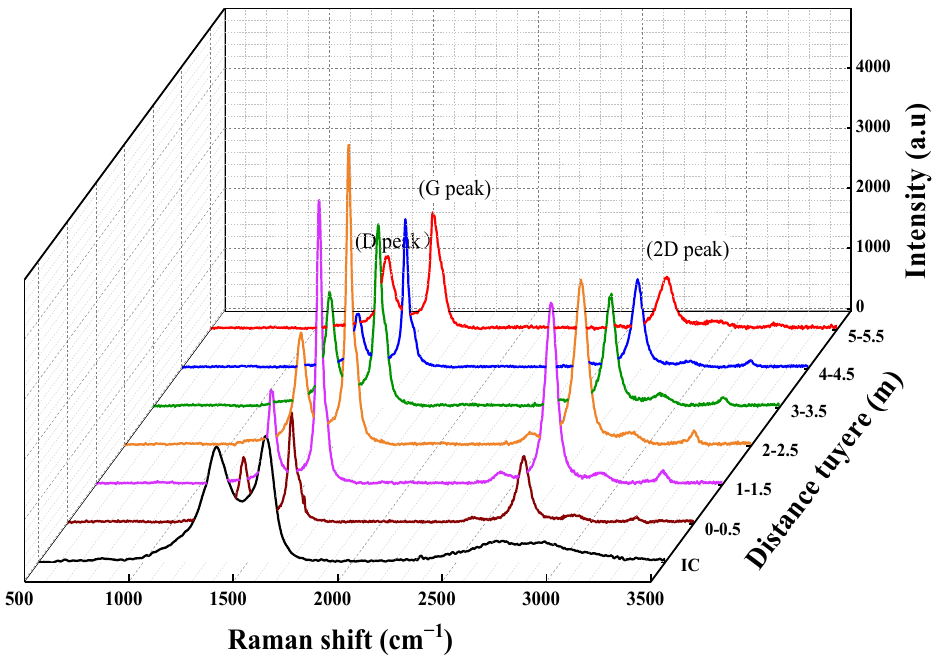
Figure 10. Raman spectrum of IC and TC.